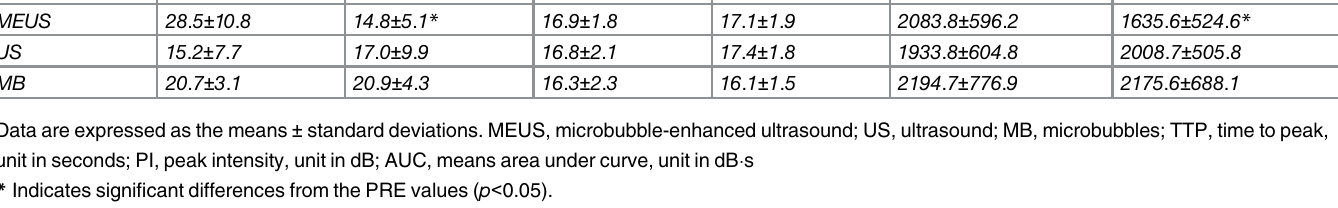
Table 2. Acoustic quantification of the time-intensity curves derived from contrast-enhanced ultrasound. Groups TTP